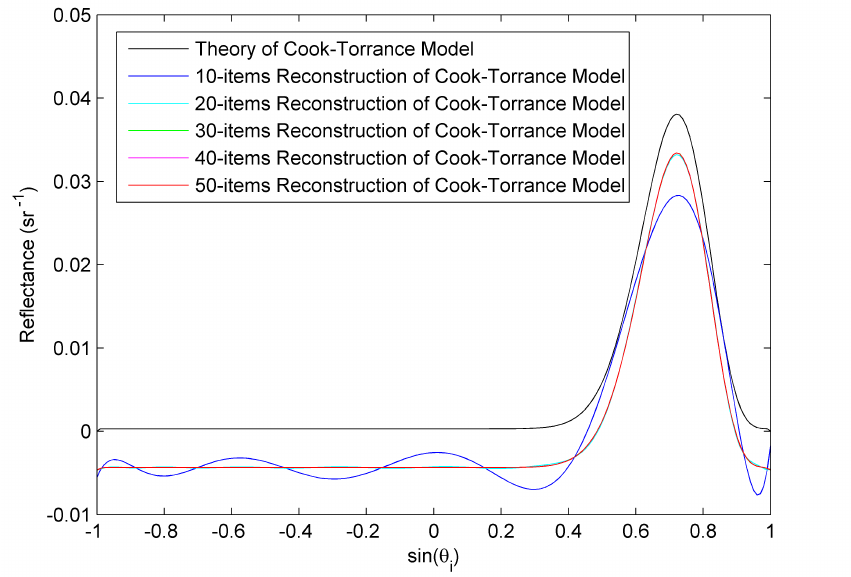
Figure 5. Diagram of the theory and reconstruction of the Cook-Torrance model.